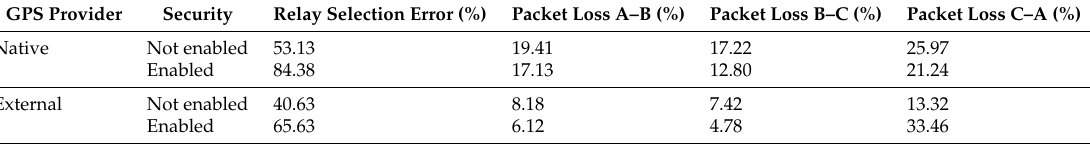
Table 6. Relay error selection and packet loss ratio for the UMB protocol, with and without enabling security services in the